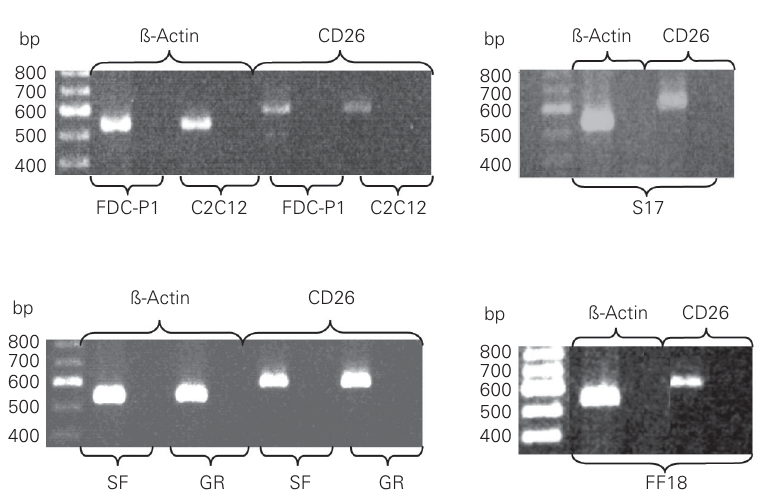
Figure 1. RT-PCR detection of DPP-IV (CD26) expression in the myeloid progenitor cell line FDC-P1, myoblast cell line C2C12, murine bone marrow stroma cell line S17, primary murine liver cell lines FF18 and GR, and primary murine newborn skin fibroblasts (SF). ß- Actin expression is used as an internal control.